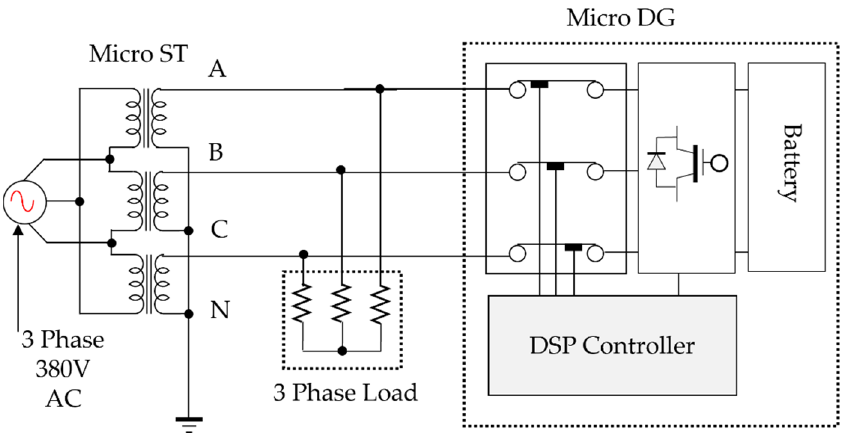
Figure 12. Illustration of the experimental set up.